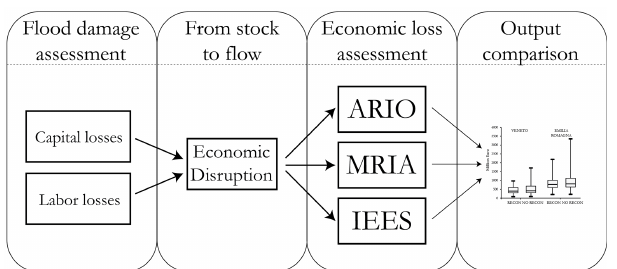
Figure 1. Overview of the different components of the comparison